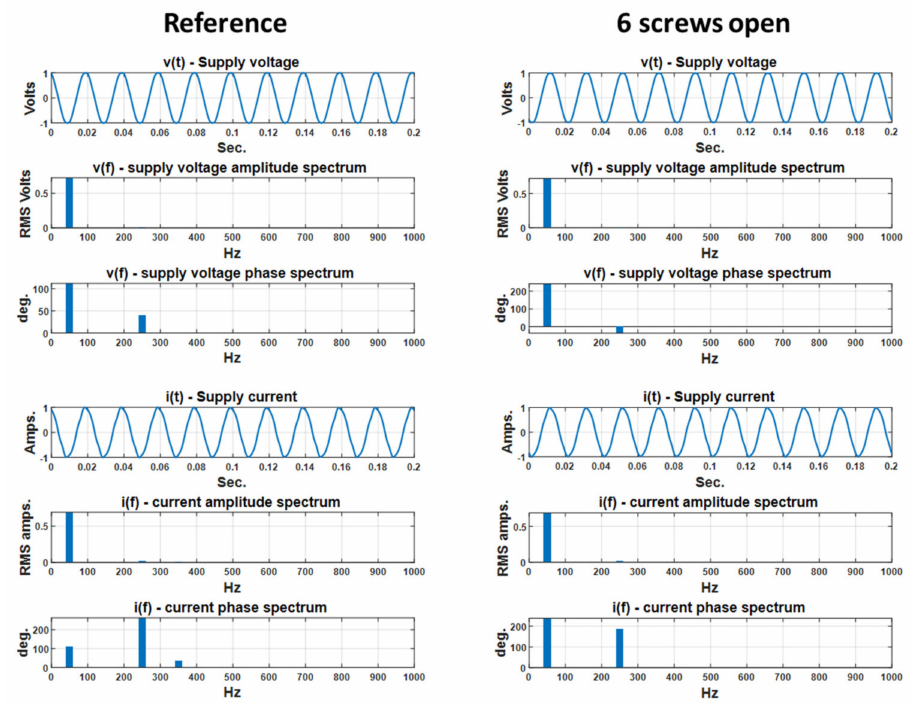
Figure 15. Normalized graphs: “non-distinguishing” anomaly (enabling mild vibration) features between all motor mounts, “6 screws open” and none opened (reference), “total voltage and current” even as amplitude spectral signature.